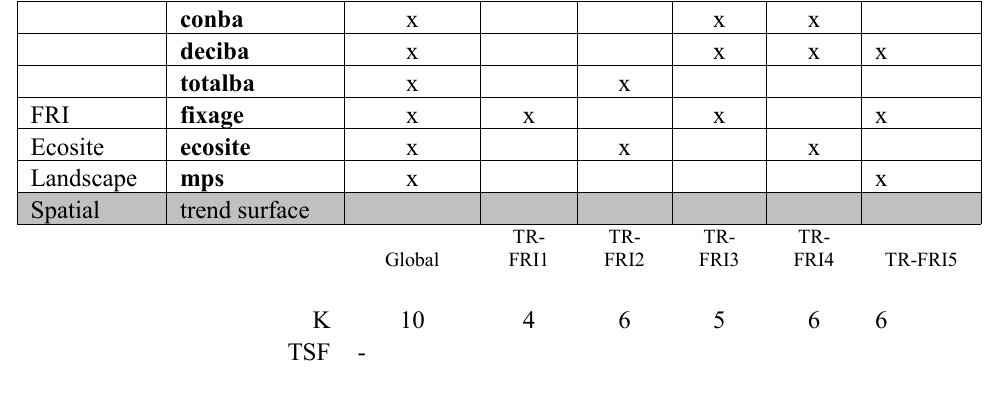
Abundance A priori selected variables are in bold text.